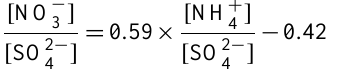
]/[SO 2 − ] vs.[NH + ]/[SO 2 − ] at differ- 3 4 4 4